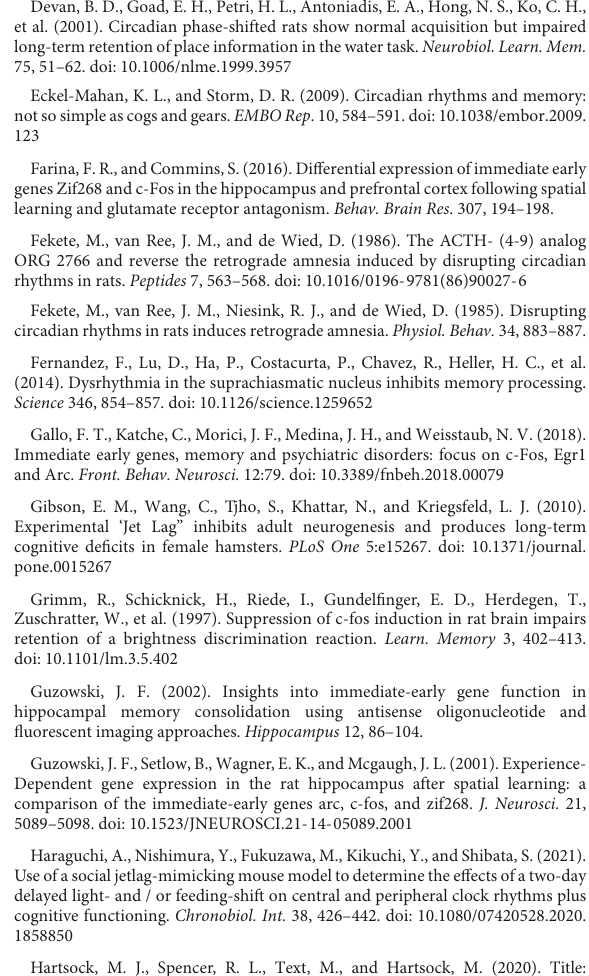
SUPPLEMENTARYFIGURE1 (A) Actograms for control rats. Gray shading represents lights off. Actograms are double plotted. (B) Actograms for T21 rats. Gray shading represents lights off. Actograms are double